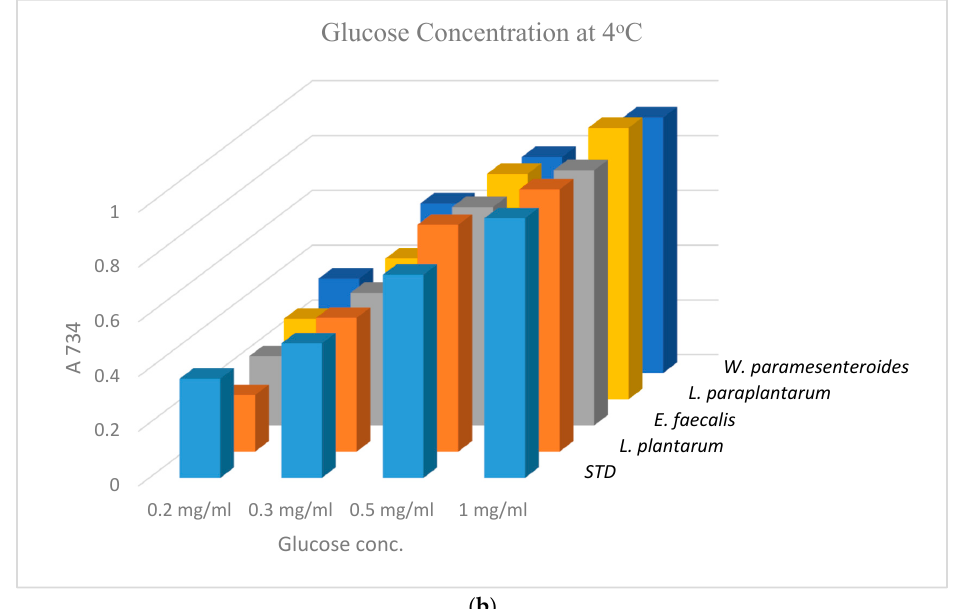
Figure 1. Glucose concentration of the marmalade at different temperatures of storage: 4 °C and 25 °C.